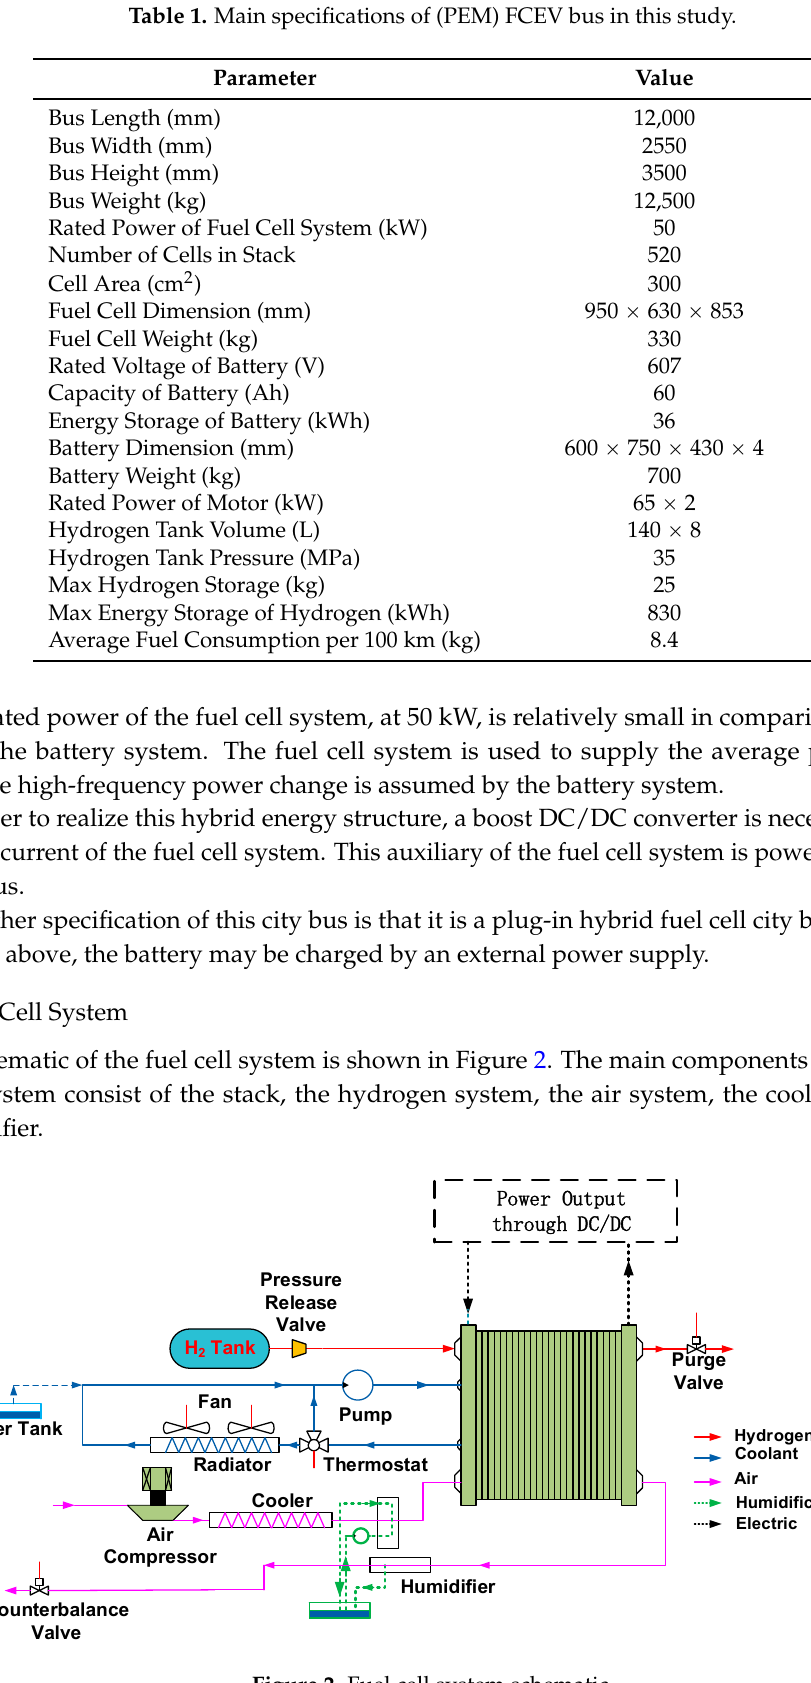
Table 1. Main specifications of (PEM) FCEV bus in this study.